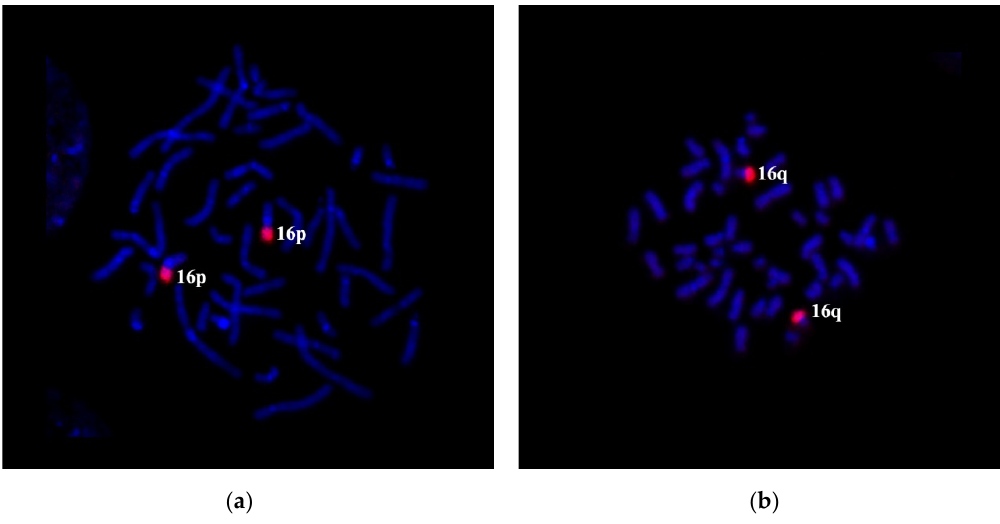
Figure 4. Quality control for microdissection DNA probes homologous for short and long arms of chromosome 16. CISS-hybridization of DNA probes PCP16p ( a ) and PCP16q ( b ) on metaphase chromosomes of a healthy donor. DAPI staining is in blue. Both 16p and 16q indicate the short and the long arm of chromosome 16,